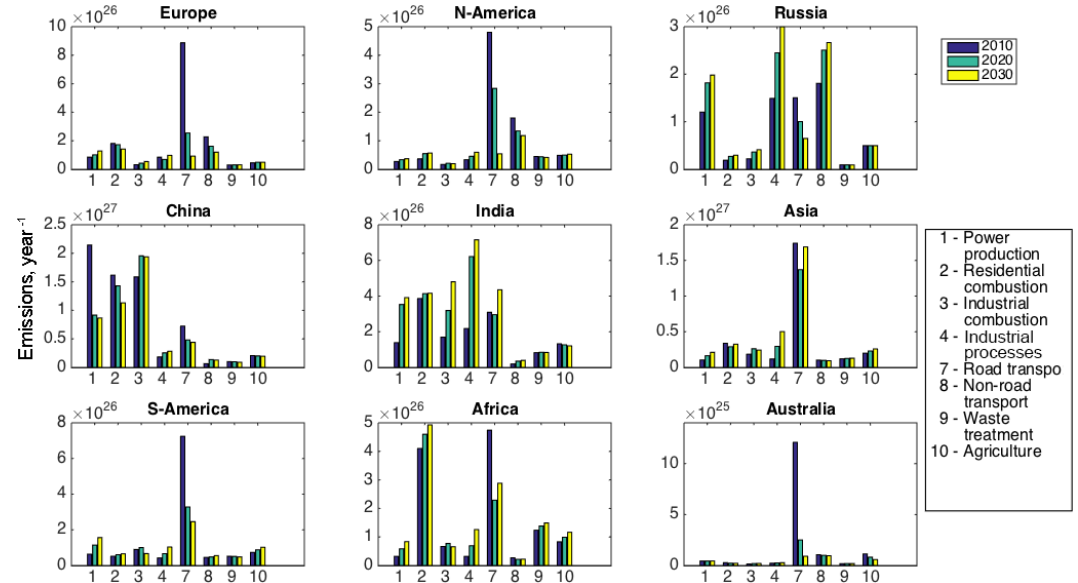
Figure 4. Contributions of different source sectors to particle number emissions in different parts of the world, from 2010 to 2030. Note the different y axis